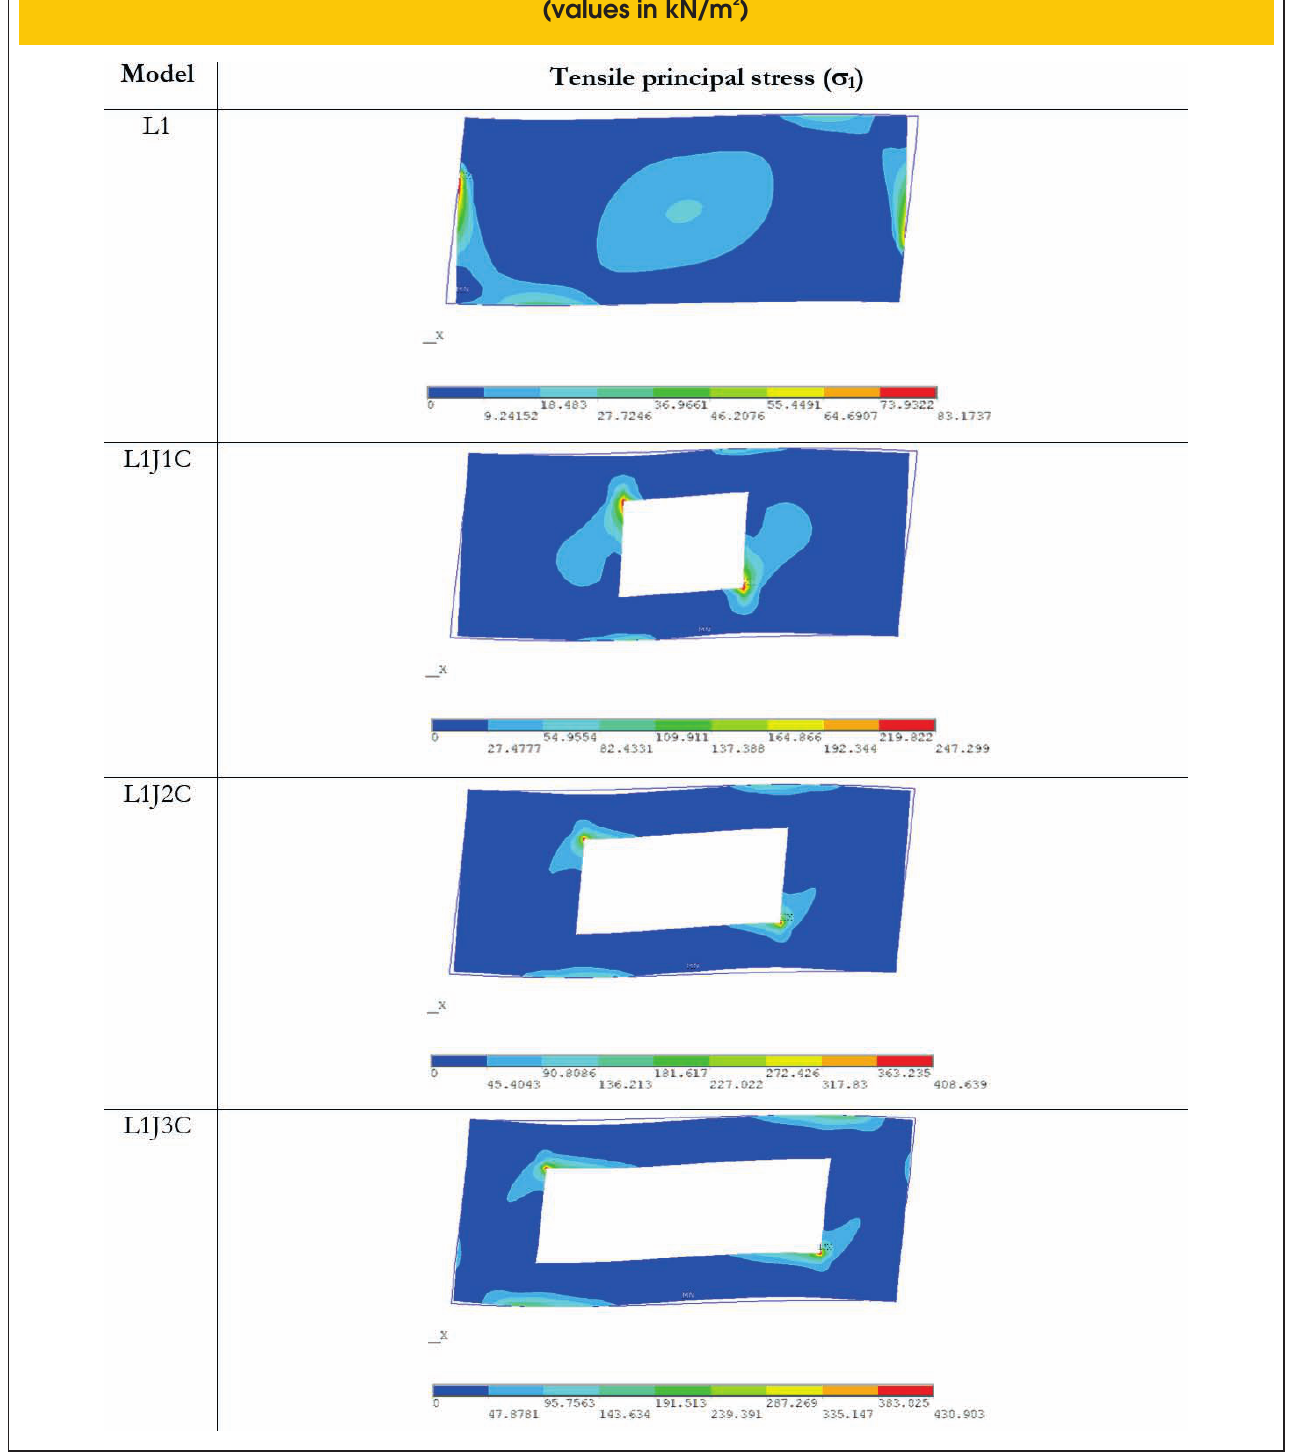
Figure 9 – Acting stresses related to diagonal tension in infill walls – FEM models